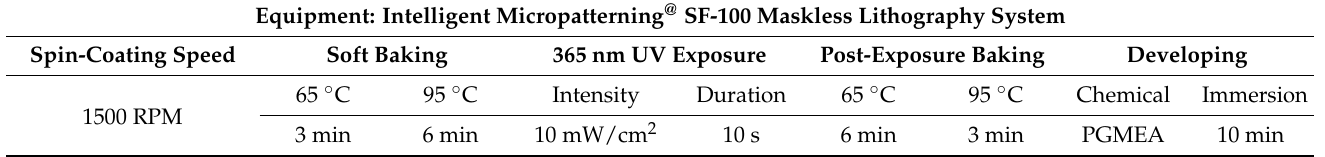
Table 4. Lithography recipe to load polymeric rigid mass to test the sensitivity of mass